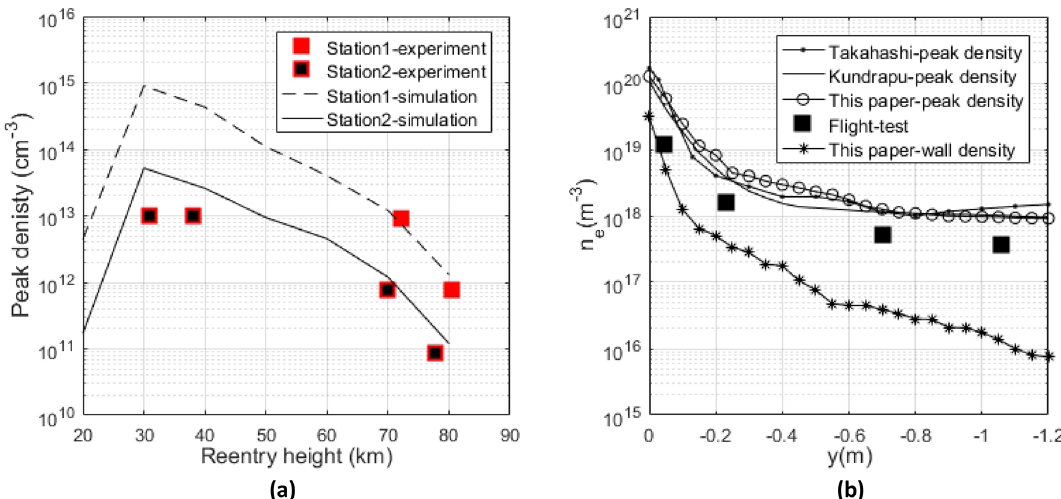
Figure 4. Comparison of electron number density distribution with flight test ( a ) and other researchers’ results ( b